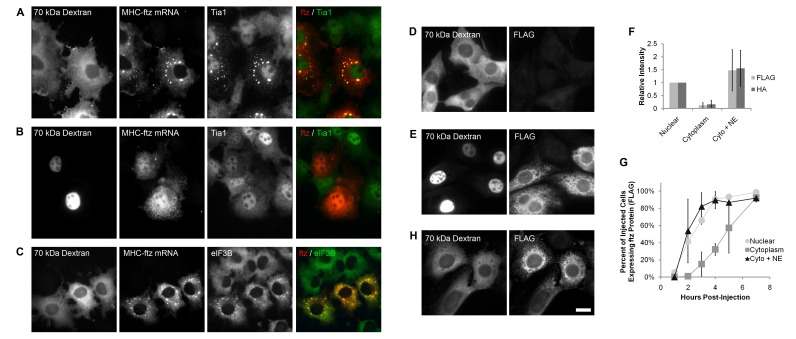
ALREX-promoting elements require a nuclear factor in order to stimulate ftz protein synthesis.(A–C) The cytoplasm (A,C) or nuclei (B) of COS-7 cells were microinjected with in vitro synthesized, capped, and polyadenylated MHC-ftz mRNA and FITC-labeled 70 kDa dextran. After 2 h cells were fixed and stained by FISH using probes against ftz mRNA and by immunofluorescence using antibodies directed against Tia1 (A–B) or eIF3B (C). Each row represents a single field of cells. Note that in cytoplasmically injected cells the MHC-ftz mRNA accumulated in cytoplasmic aggregates that are enriched in Tia1 and eIF3B (see overlays in (A and C)). (D–E, H) NIH-3T3 cells were microinjected with FITC-labeled 70 kDa dextran and in vitro synthesized, capped, and polyadenylated MHC-ftz mRNA, which was either untreated (D–E) or pre-incubated with HeLa nuclear extract (H). The cells were incubated for 3 h then fixed and stained by immunofluorescence using antibodies directed against the FLAG epitope. Each row represents a single field of cells that were microinjected into the cytoplasm (D,H) or nucleus (E) as determined by the distribution of 70 kDa dextran. Note that when MHC-ftz mRNA is introduced directly into the cytoplasm it is translated only if it was pre-incubated with nuclear extract. Scale bar = 20 µM. (F–G) NIH-3T3 cells were microinjected with MHC-ftz mRNA and FITC-labeled 70 kD dextran, alone or with HeLa nuclear extract (“+NE”), in the nucleus or cytoplasm. Cells were fixed, then immunostained for either FLAG (F–G) or HA (F) epitopes. (F) The total integrated intensity of FLAG and HA immunofluorescence was quantified for cells, 3 h post-injection. (G) The percentage of microinjected cells expressing ftz protein, as measured by the appearance of FLAG immunofluorescence, was quantified for each time point post-injection. Each data point/bar in (F–G) consists of an average of three experiments, each of which consisting of >100 cells. Error bars represent the standard deviation between experiments.